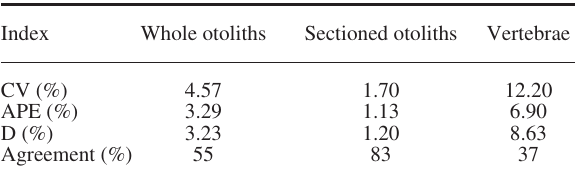
Table 4. – Measure of precision for age readings on Aphanopus carbo between reader 1 and reader 2.